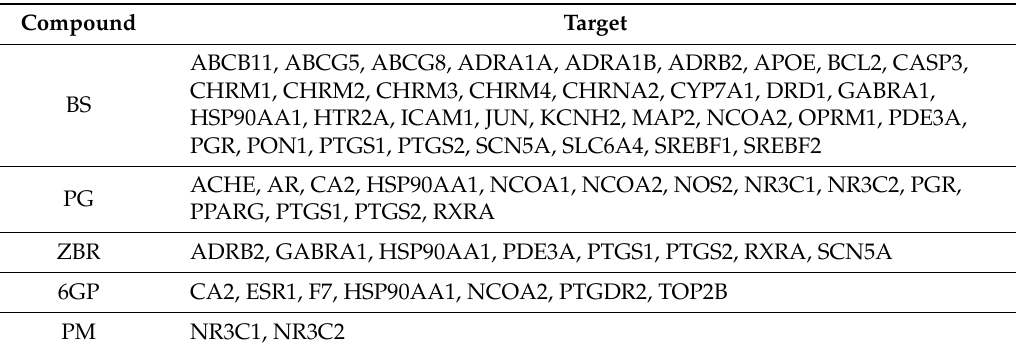
Table 2. Active compounds and associated